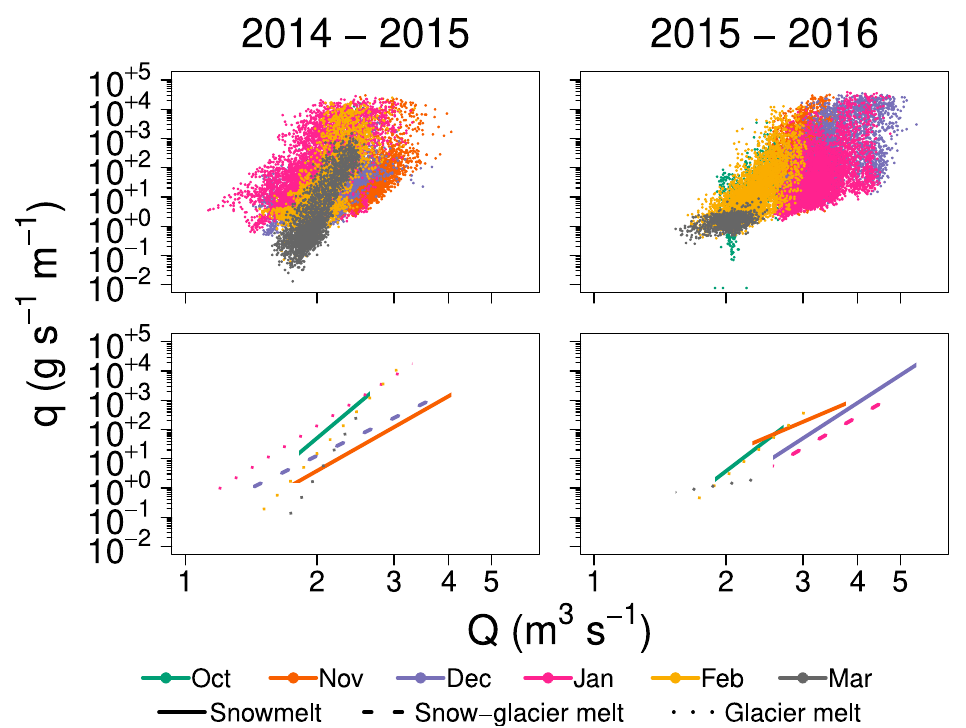
Figure 9. Water discharge (Q) and bedload transport rates (qs) relationship grouped by month in the two ablation seasons at MS-D in the Estero Morales basin. The plots show the data points (above) and the regressions calculated by splitting the data series per month.